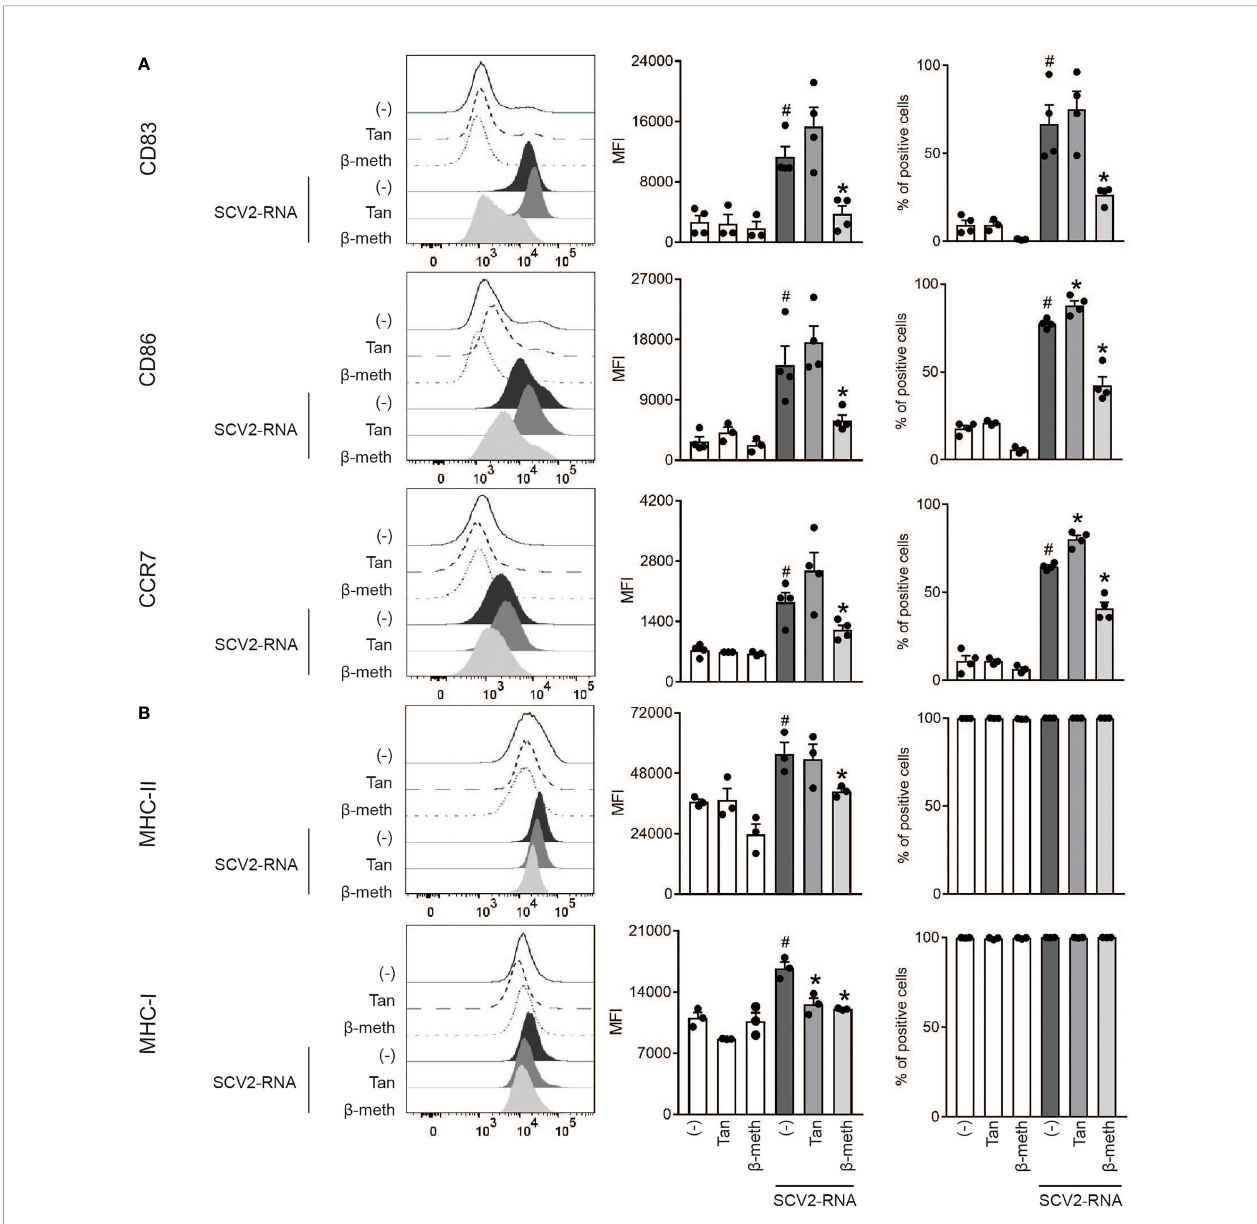
FIGURE 2 | Effect of Tanimilast on moDC phenotypic maturation induced by SCV2-RNA. (A, B) moDCs were pre-treated or not (-) with either Tanimilast (Tan) or b -methasone ( b -meth) (both at 10 -7 M) for 1 hour and subsequently stimulated or not with SCV2-RNA for 24 hours. The surface expression of activating markers CD83, CD86, CCR7 (A) and of antigen presenting molecules MHC-I, MHC-II (B) were evaluated by FACS analysis. Data are expressed as representative cyto fl uorimetric pro fi les (left panels),as the mean ± SEM (n=3-4) of the Median Fluorescence Intensity (MFI) (center panels) and of the percentage of positive cells (right panels). # P < 0.05 versus (-) and *P < 0.05 versus SCV2-RNA by one-way ANOVA with Dunnett ’ s post-hoc